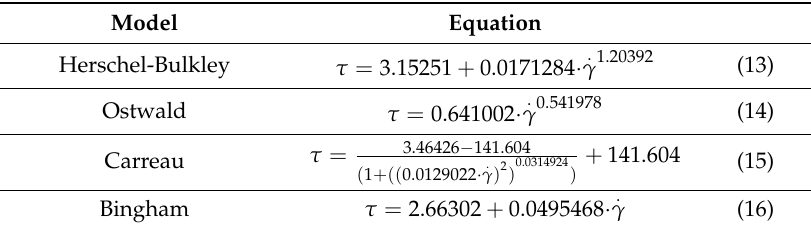
Table 5. Mathematical formulas of rheological models for the WE43B